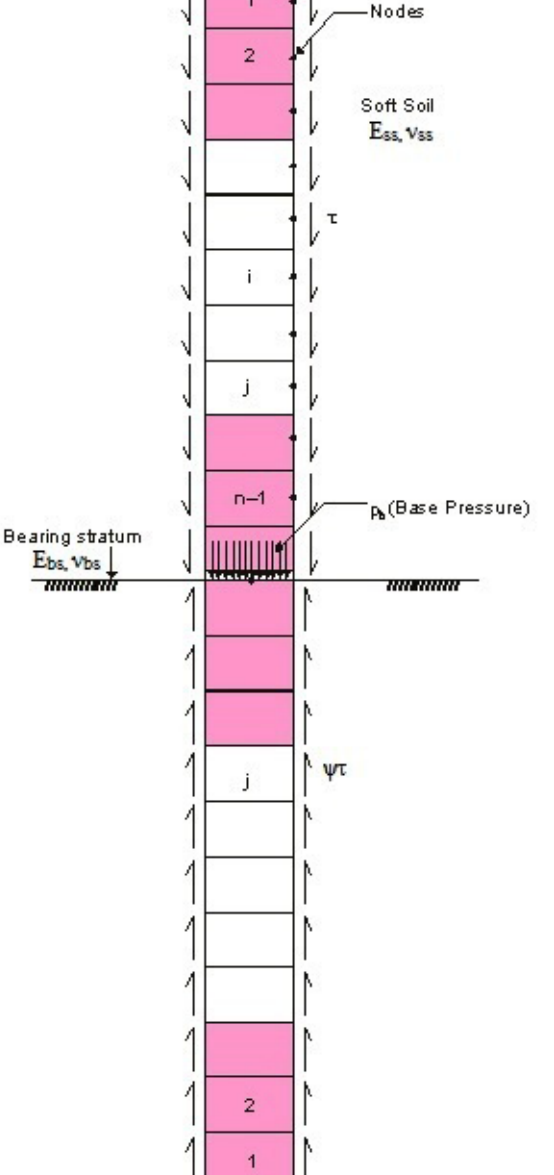
Figure 2: Basic mirror image methodology for